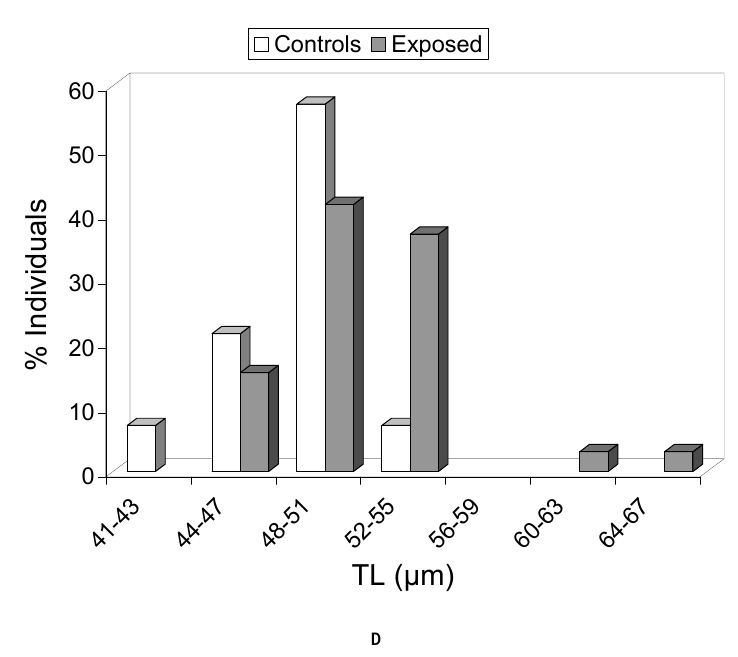
FIGURE 2. Distribution of SCE frequencies (A), MN frequencies (B), BNMN frequencies (C), and TL (D) in the control and exposed